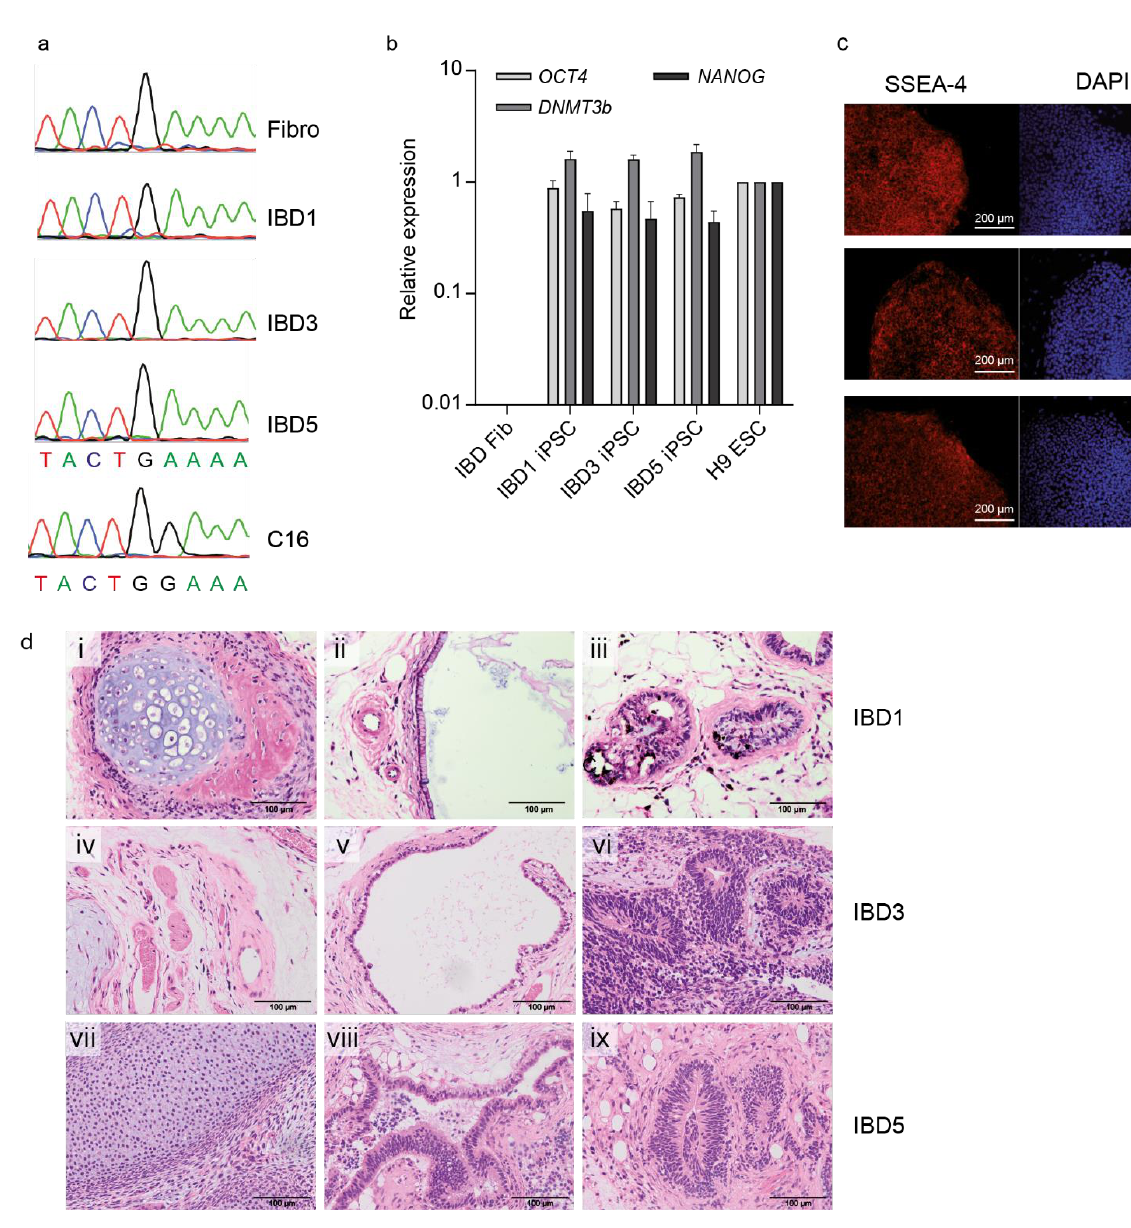
Figure 1. Generation of iPSCs from an IL-10RB -/- VEO-IBD patient. ( a ) Sanger sequencing to detect the IL-10RB mutation (c.G477A) in patient’s fibroblasts (Fib) and VEO-IBD iPSC clones (IBD1, IBD3, IBD5). Healthy C16 iPSC served as a control. ( b ) RT-qPCR expression analysis of endogenous pluripotency genes OCT4 , NANOG , and DNMT3b in VEO-IBD iPSC and fibroblasts in relation to H9 ESCs (set to one, mean of technical replicates). ( c ) Immunofluorescence microscopy to detect pluripotency marker SSEA-4 expression on the surface of IBD iPSCs. DAPI was used for nuclei staining. Bars correspond to 200 µm. ( d ) Microscopic analyses of teratoma tissue generated from VEO-IBD iPSC clones after subcutaneous injection into immunodeficient mice. Hematoxylin and Eosin staining indicated mature tissues derived from all three germ layers: IBD1 (i–iii): cartilage (mesoderm, i), intestinal epithelium (endoderm, ii), neural tissue (ectoderm, iii). IBD3 (iv–vi): smooth muscle (mesoderm/ectoderm, iv), ciliated airway epithelium (endoderm, v), neural tissue (ectoderm, vi). IBD5 (vii–ix): cartilage (mesoderm, vii), intestinal epithelium (endoderm, viii), neural tissue (ectoderm, ix). Bars correspond to 100 µm.